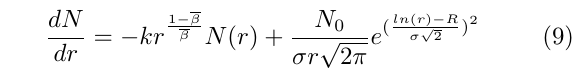
Fig. 12. log( N ( r )) in function of r high r : r 2 = 0 . 97